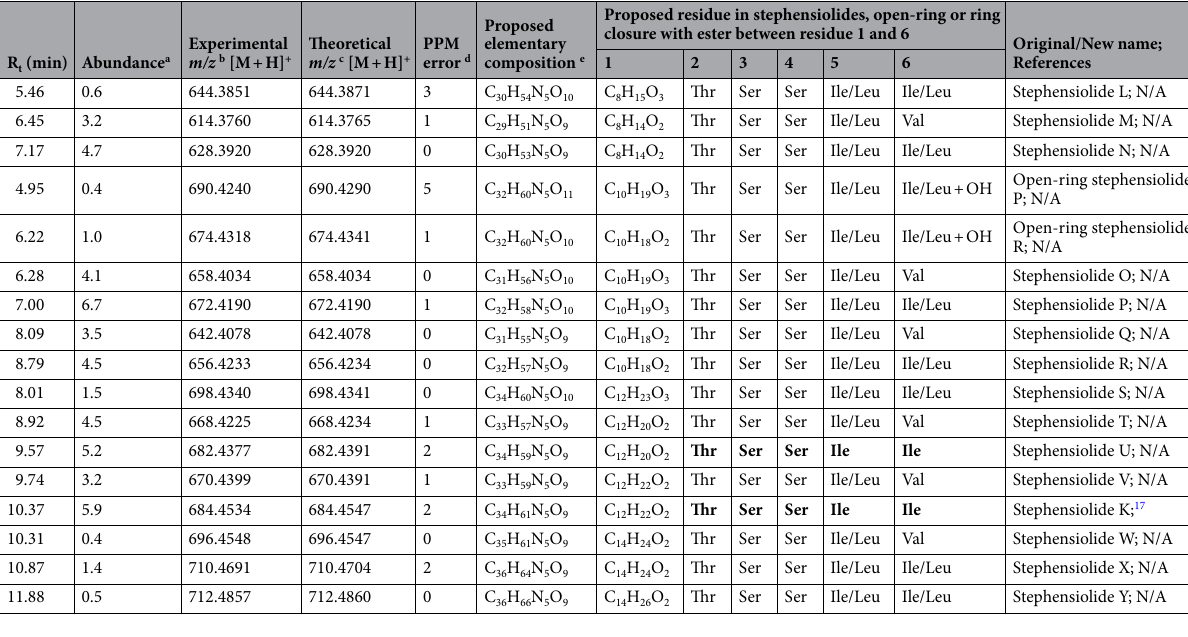
Table 1. Summary of the chemical parameters and proposed structure of stephensiolide lipopeptides in this study. Sequences in normal font are proposed from the accurate M r , elemental composition and partial sequencing with UPLC-MS E . Sequences in bold font were elucidated/confirmed with 1 H NMR. N/A—Not applicable; No.—Compound number; R t —Retention time obtained with UPLC-MS within the NP10 extract. a Abundance was calculated from the UPLC-MS analyses of the crude extract. b Experimental protonated M r of a compound in the selected extract was calculated using the Time-of-Flight (TOF) transform function in the MassLynx 4.2 software package. c Theoretical protonated M r of compound was calculated using de novo M r calculation and verification with ChemDraw Ultra 12.0 software package. d Mass error in × 10 6 . e Theoretical molecular formula of compound was calculated using (cid:30) ChemDraw Ultra 12.0 software package and experimental molecular formula was confirmed using the MassLynx 4.2 software package. Refer to supplementary data for the UPLC-MS E sequence and 10.31 contained an internal fragment of m/z 405.23, with compounds m/z 658.4034, 614.3760, 642.4078, 668.4225, 670.4399 and 696.4548 [M + H] + , respectively, containing either a Ser-Ser-Val-Ile/Leu + H, OH or a Ser-Ser-Ile/Leu-Val + H, OH fragment (Fig. 2). There were no peaks observed with an internal fragment of m/z 391.22 for Ser-Ser-Val-Val + H, OH (results not shown). The preliminary screening for internal ions indicates that this strain is predominantly producing stephensiolides with an Ile/Leu as residue 5. These stephensiolide analogues are thus distinct from previously described stephensiolides which contain a Val as residue 5 (except for StpK). Fragmentation profile analysis using the UPLC-MS E data was subsequently conducted to elucidate the structures of these new stephensiolide analogues. For most of these lipopeptides, the whole sequence of b-ions (and dehydrated b-ions) were detected in the fragmentation profile and in some cases the corresponding a-ions were also observed (Supplementary Table S3). The CID fragmentation analysis putatively confirmed the structure of m/z 684.4534 [C 34 H 61 N 5 O 9 + H] + (compound 14 ) as C 13 H 22 O 2 -Thr-Ser-Ser-Ile/Leu-Ile/Leu (Table 1 and Supplementary Table S3). Furthermore, 1 H NMR analysis of 14 then confirmed the structure as